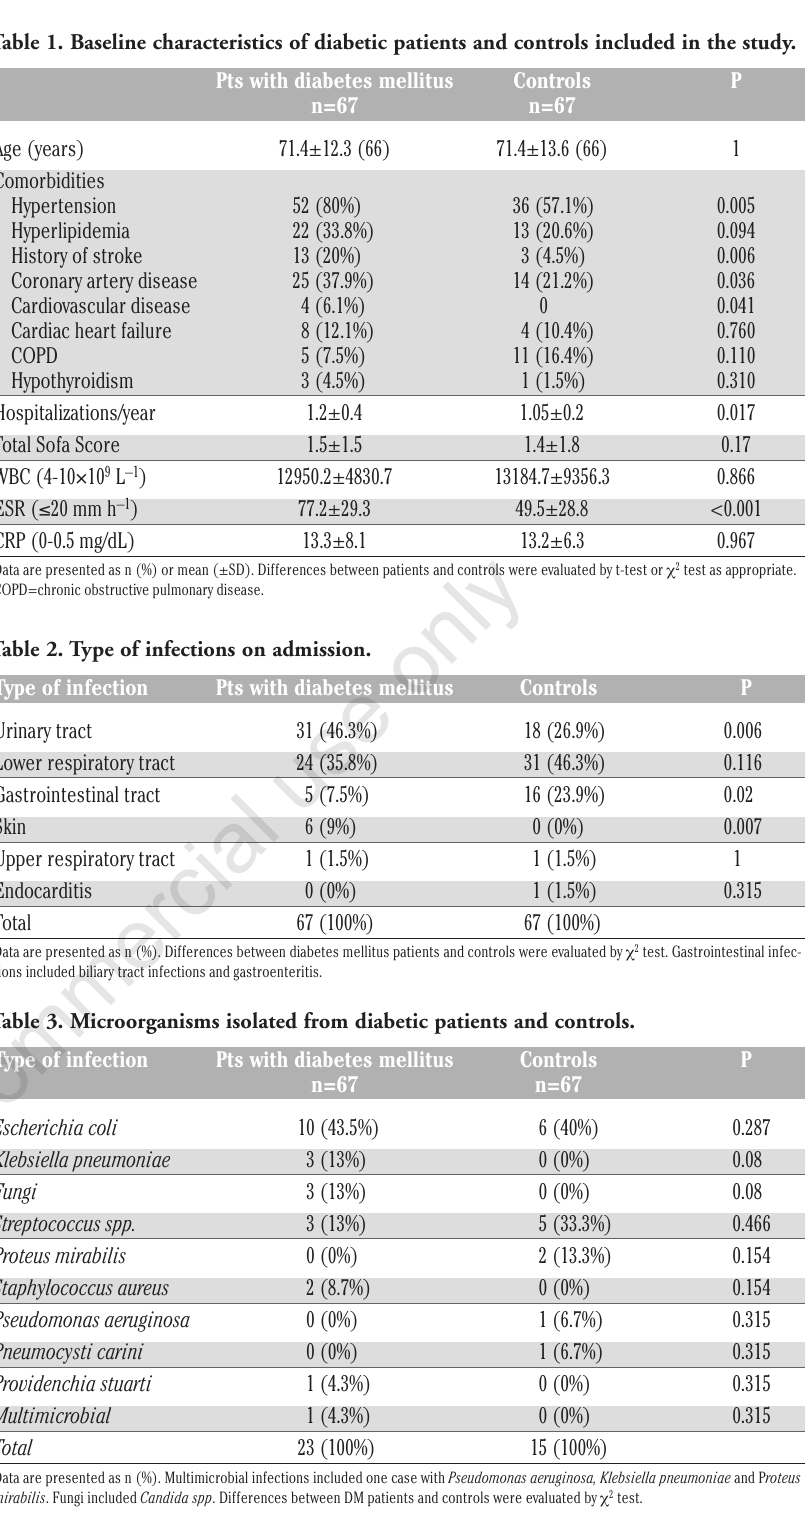
(Table 4). Baseline serum glucose levels in